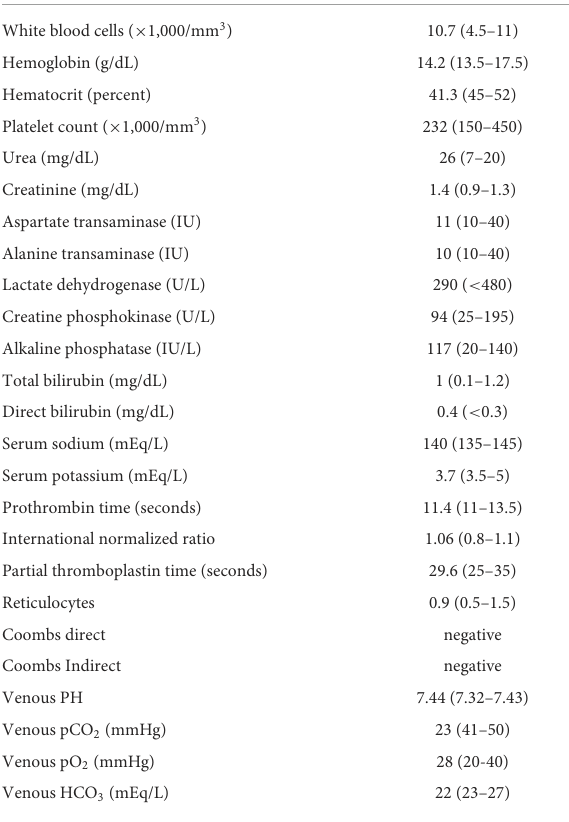
TABLE 1 On-arrival lab test